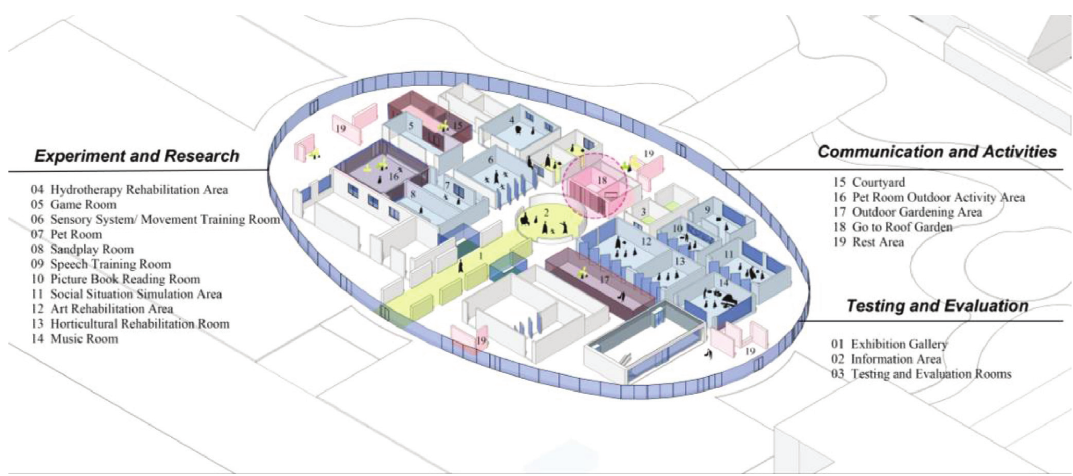
Figure 11: Design model of functional rooms.